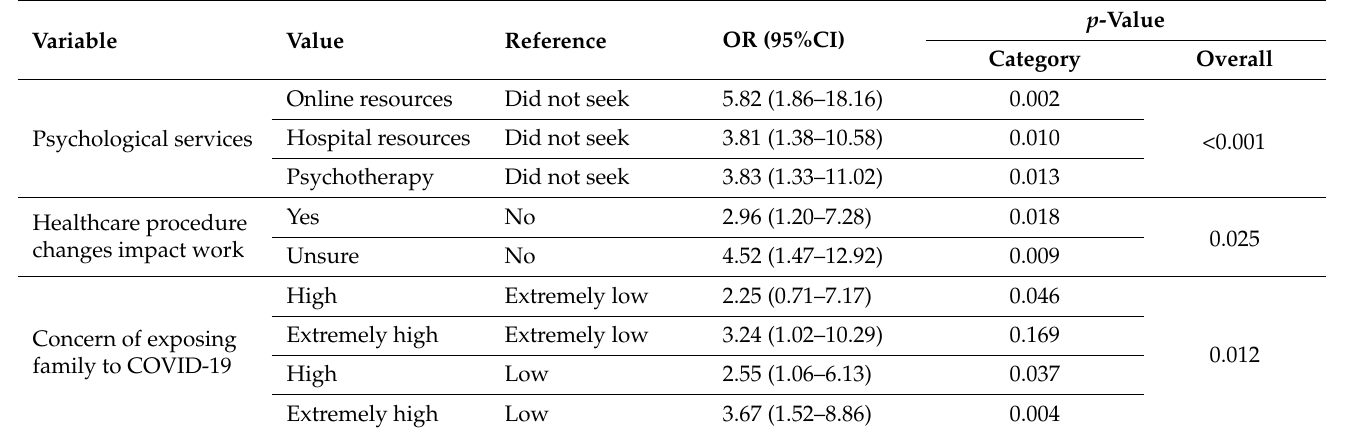
Table 6. Risk factors for anxiety by binary logistic